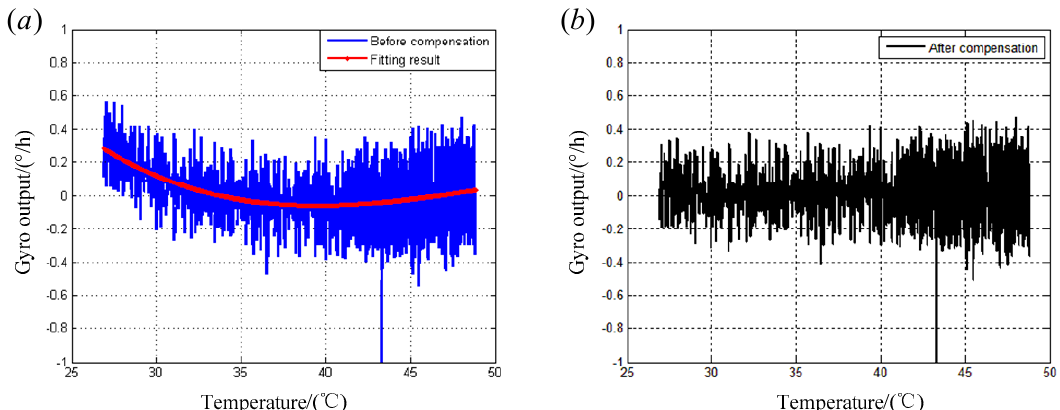
Figure 11. Temperature compensation result; ( a ) The fitting result of the data; ( b )The result after temperature compensation.